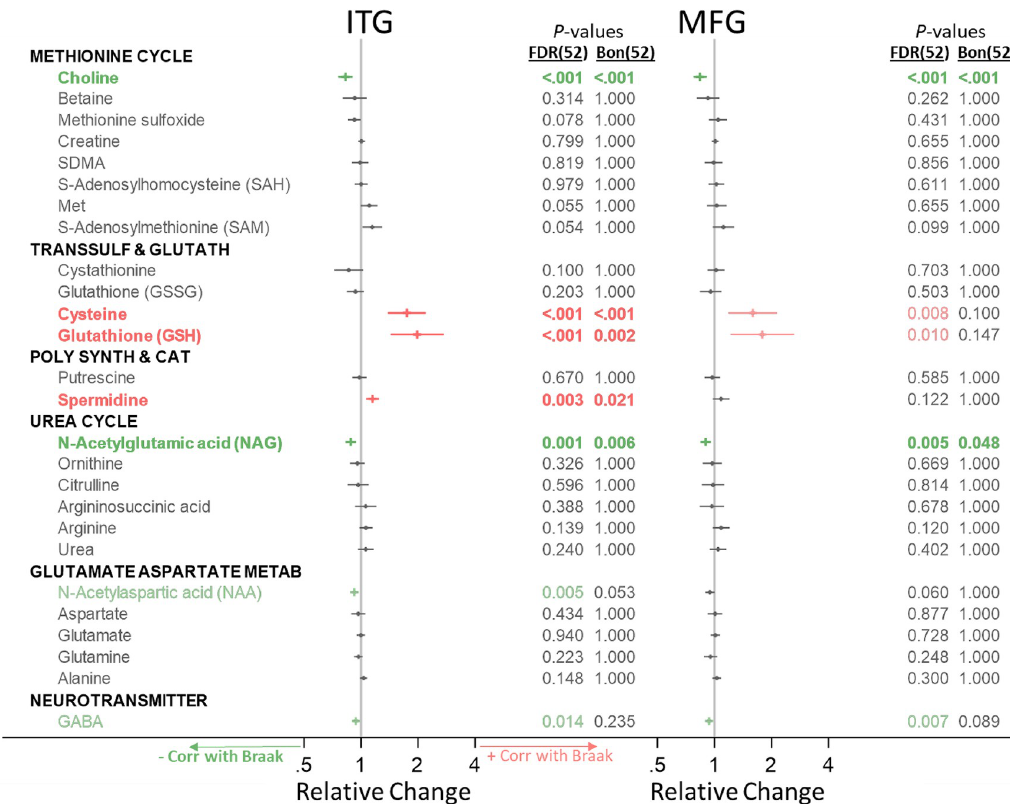
Fig 3. Associations between category-specific metabolites and neurofibrillary pathology (Braak). Metabolites in green or red (not bold) were significant after FDR correction for 52 comparisons; metabolites in green or red (bold) were also significant after Bonferroni correction for 52 comparisons. Associations with pathology were tested using linear mixed-effects models for each metabolite category. Bon, Bonferroni; CERAD, Consortium to Establish a Registry for Alzheimer’s Disease; FDR, false discovery rate; Glutamate Aspartate Metab, glutamate-aspartate metabolism; ITG, inferior temporal gyrus; MFG, medial temporal gyrus; Poly Synth & Cat, polyamine synthesis and catabolism; Transsulf and Glutath, transsulfuration and glutathione